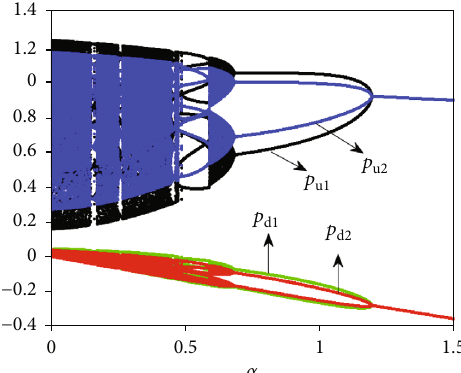
, λ Þ with di ff erent values of α . 1 2